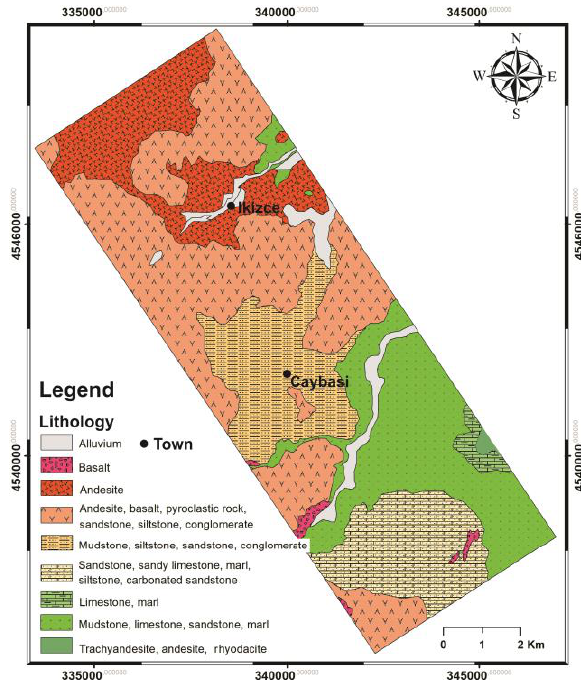
Figure 4. Lithological map of the study area (Altun, 2011).